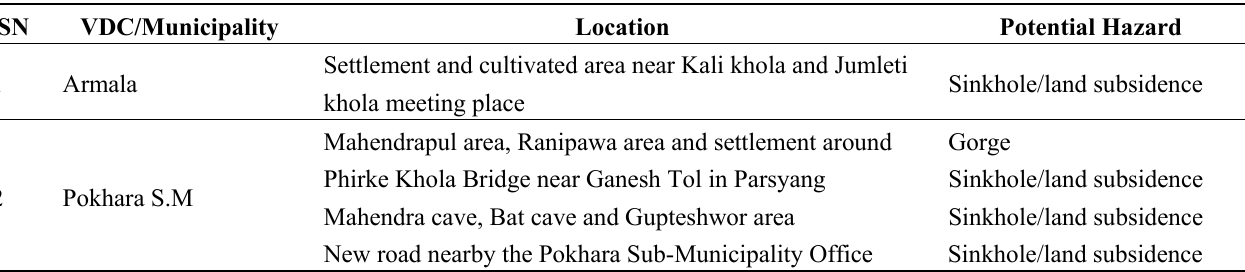
Table 2. Sinkhole and land subsidence hazard areas.